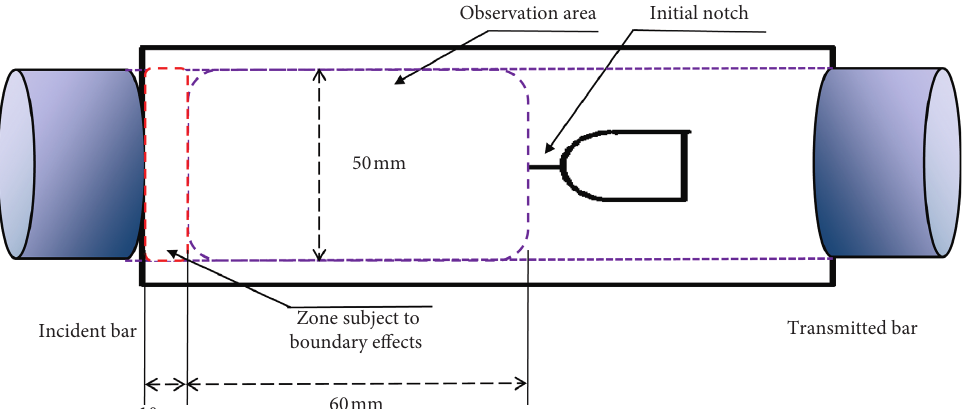
Figure 7: Schematic diagram of the specimen.